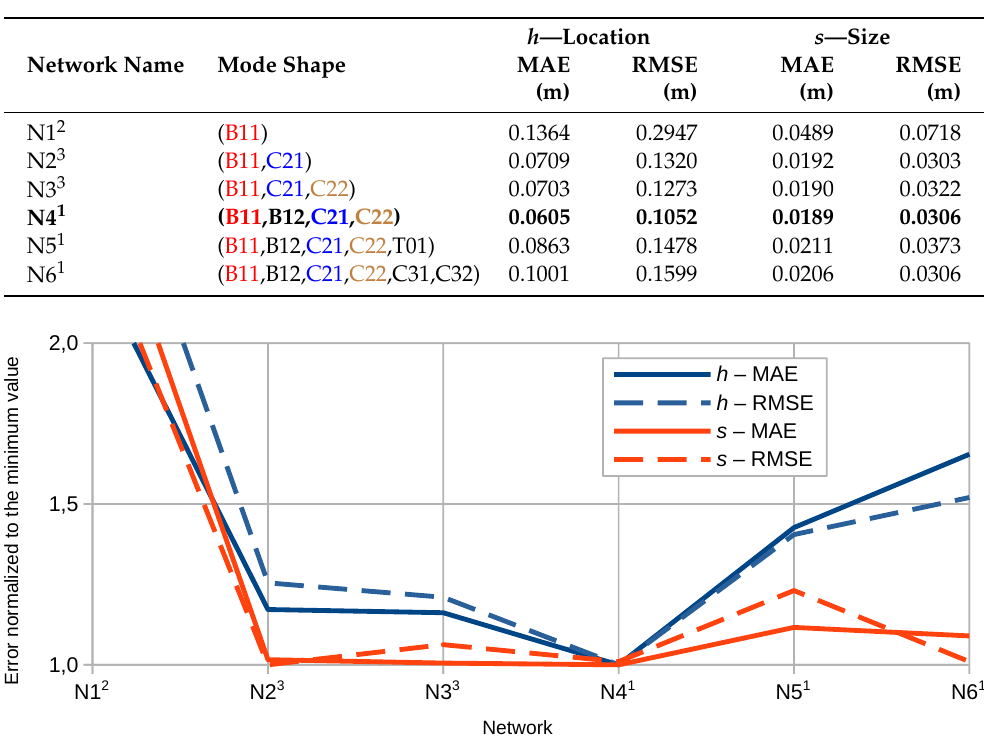
Table 9. The best results of the identification of { h , s } .